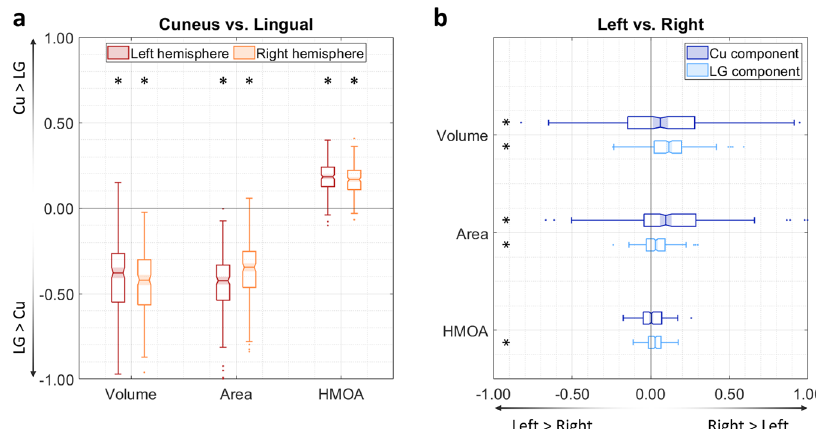
Fig. 6 Macrostructural and microstructural assessment of the MOLT. These box charts summarise the comparisons between the MOLT ’ s components within each hemisphere and across hemispheres in 200 subjects. a In both hemispheres, the lingual gyrus (LG) component has a larger volume, distributes to a wider occipital surface, and has a lower fi bre density (as indicated by its lower HMOA) compared to the cuneus (Cu) component (values were derived using Eq. 1). b Both the Cu and LG components of the MOLT tend to exhibit a slight lateralisation towards the right hemisphere (values derived using Eq. 2). Within the box charts, the notch and shaded bar represent the median value, the edges of the box correspond to the upper and lower quartiles, and the whiskers extend to the maximum and minimum non-outlier values. Asterisks indicate that the mean of the corresponding distribution is signi fi cantly different from zero after Bonferroni correction. Detailed descriptions of these metrics are available in the Methods section. Full descriptive statistics of these metrics and comparisons are reported in Supplementary Tables 2 and